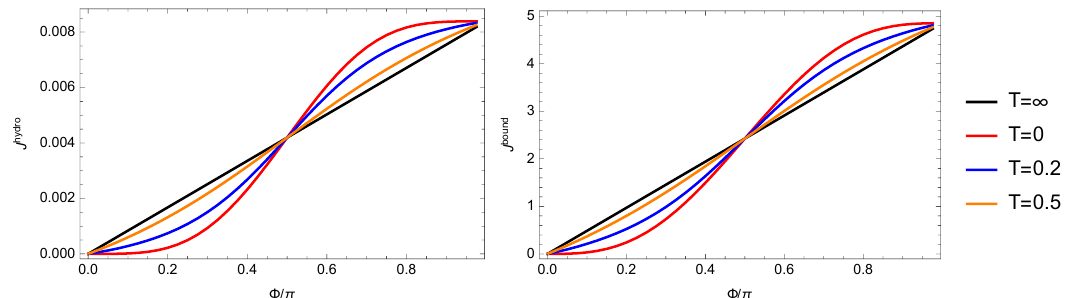
Figure 4: Amplitudes (25) of the hydrodynamic and oscillating contributions to the current (24) at large times as functions of the initial particle density in the left chain, / N = Φ /π , computed for various temperatures. The hopping constant at the link N f is (cid:34) =